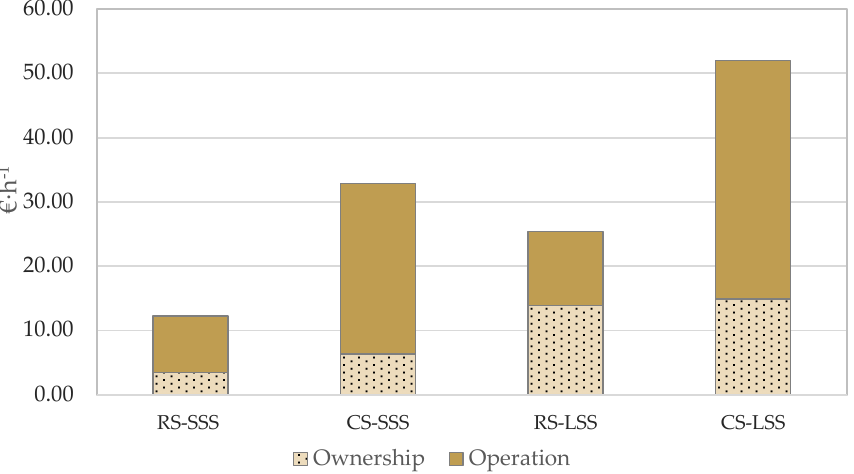
Figure 3. Ownership cost and operation cost contribution to hourly cost (RS—Robotic System; CS—Conventional System; SSS—Small-Scale Scenario; LSS—Large-Scale Scenario).